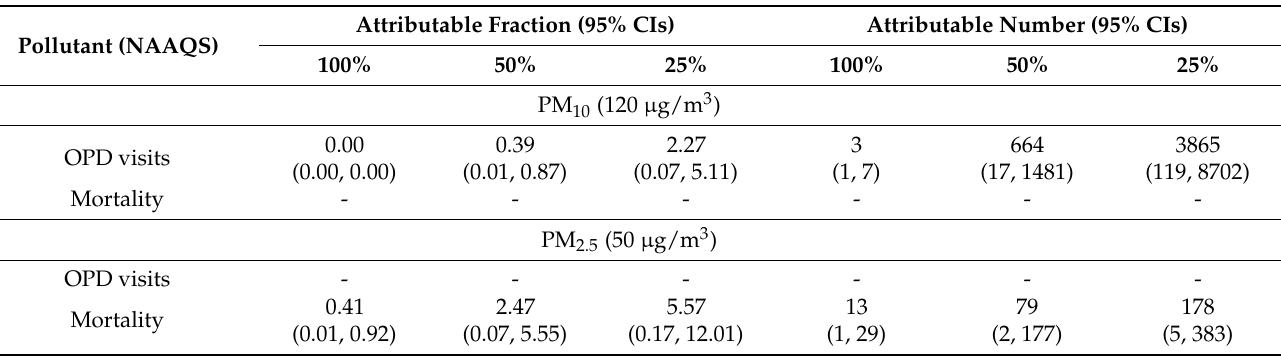
Table 10. Attributable fractions and attributable numbers of outpatient department (OPD) visits and mortalities for influenza and pneumonia caused by air pollutant concentrations in the